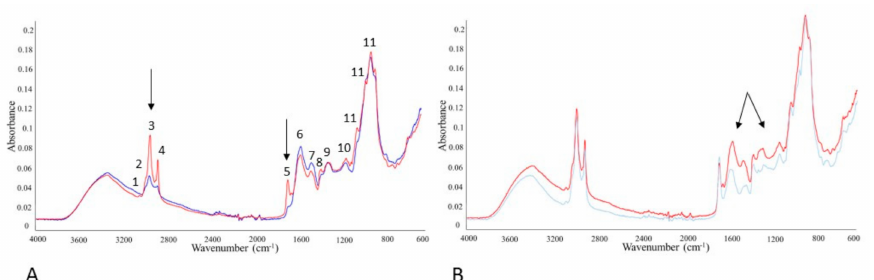
Figure 3. Raw FTIR-ATR spectra of bioproduct obtained by solid-state fermentation of Umbelopsis isabellina CCF2412. ( A ) Spectra of fermented wheat bran-based bioproduct with 0% animal fat (blue line) and 30% animal fat addition (red line); ( B ) Spectra of non-fermented (blue line) and fermented (red line) CM-based biorpoduct. Peak numbers correspond to: (1) =C-H stretching in lipids; (2) -C-H (CH 3 ) stretching in lipids and hydrocarbons; (3) -C-H (CH 2 ) stretching; (4) CH 2 /CH 3 stretching in lipids and hydrocarbons; (5) C=O ester bond stretching in lipids, esters and polyesters; (6) -C=O stretching, α -Helix Amide I in proteins; (7) N-H bending and C-N stretching, Amide II in proteins; (8 and 9) CH 2 /CH 3 deformations in lipids; (10) –P=O stretching of phospholipids, polyphosphates and nucleic acids; (11) C-O-C/C-O stretching in polysaccharides; peak assigned according to Kosa et al. [42] and Dzurendova et al. [43]. Black arrows indicate significant changes in lipid-specific region (A) and polysaccharides region